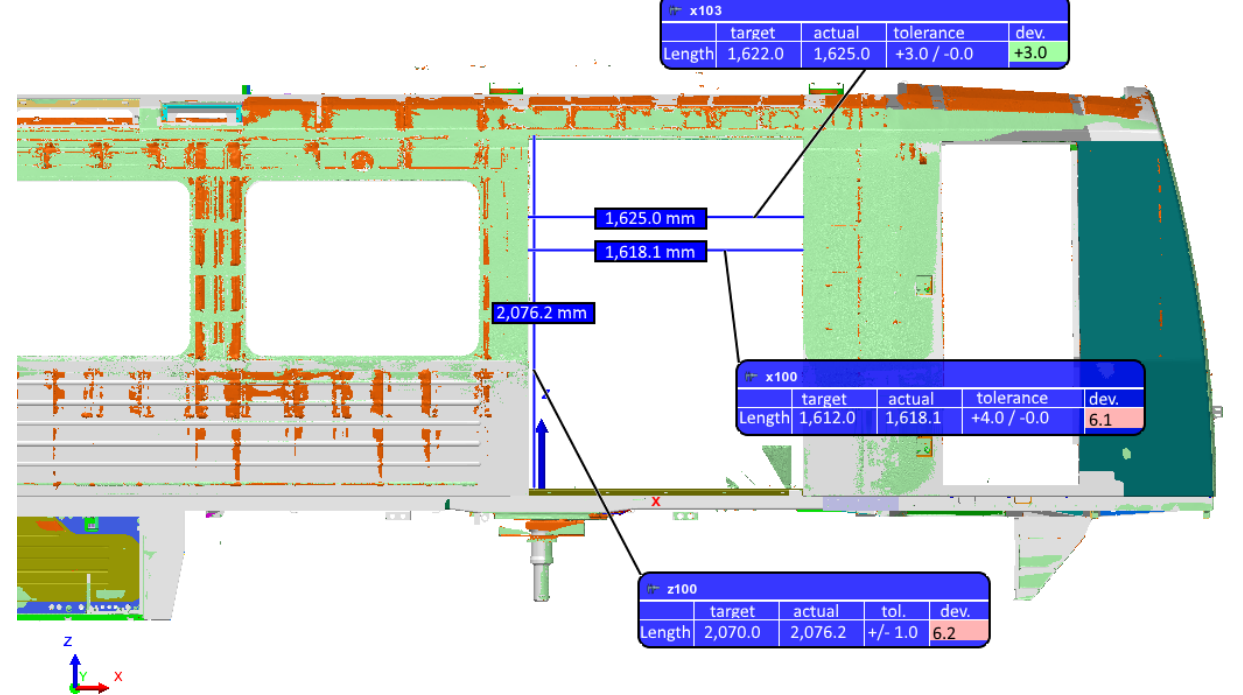
Figure 5. The x and y dimensions of a door cutout, derived from the point cloud.